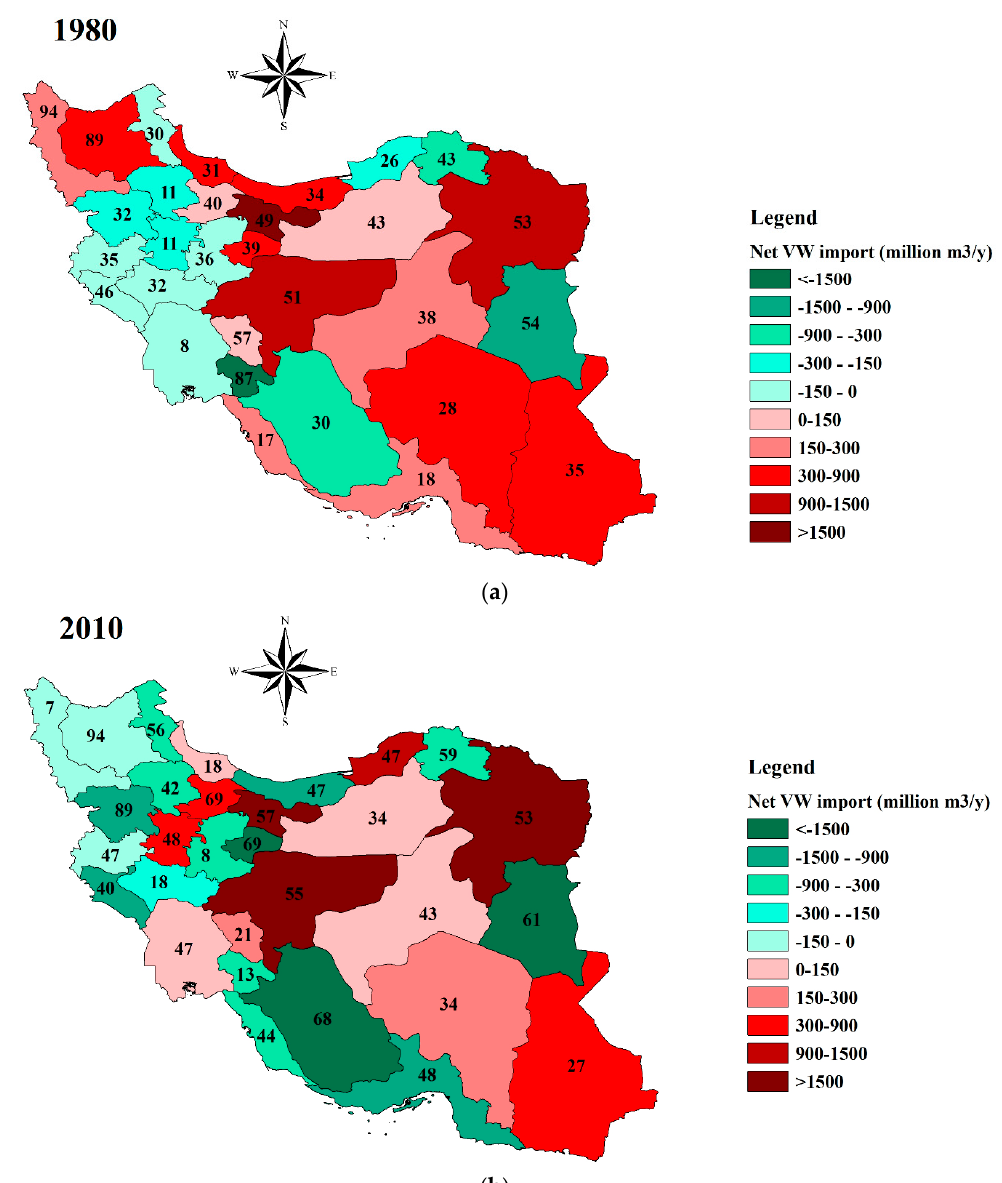
Figure 9. Net total virtual water (VW) import per province in Iran, in the years 1980 ( a ) and 2010 ( b ). Positive signs refer to net virtual water import; negative signs refer to net virtual water export. The figure within each province denotes the percentage of blue water in the VW import of the province.